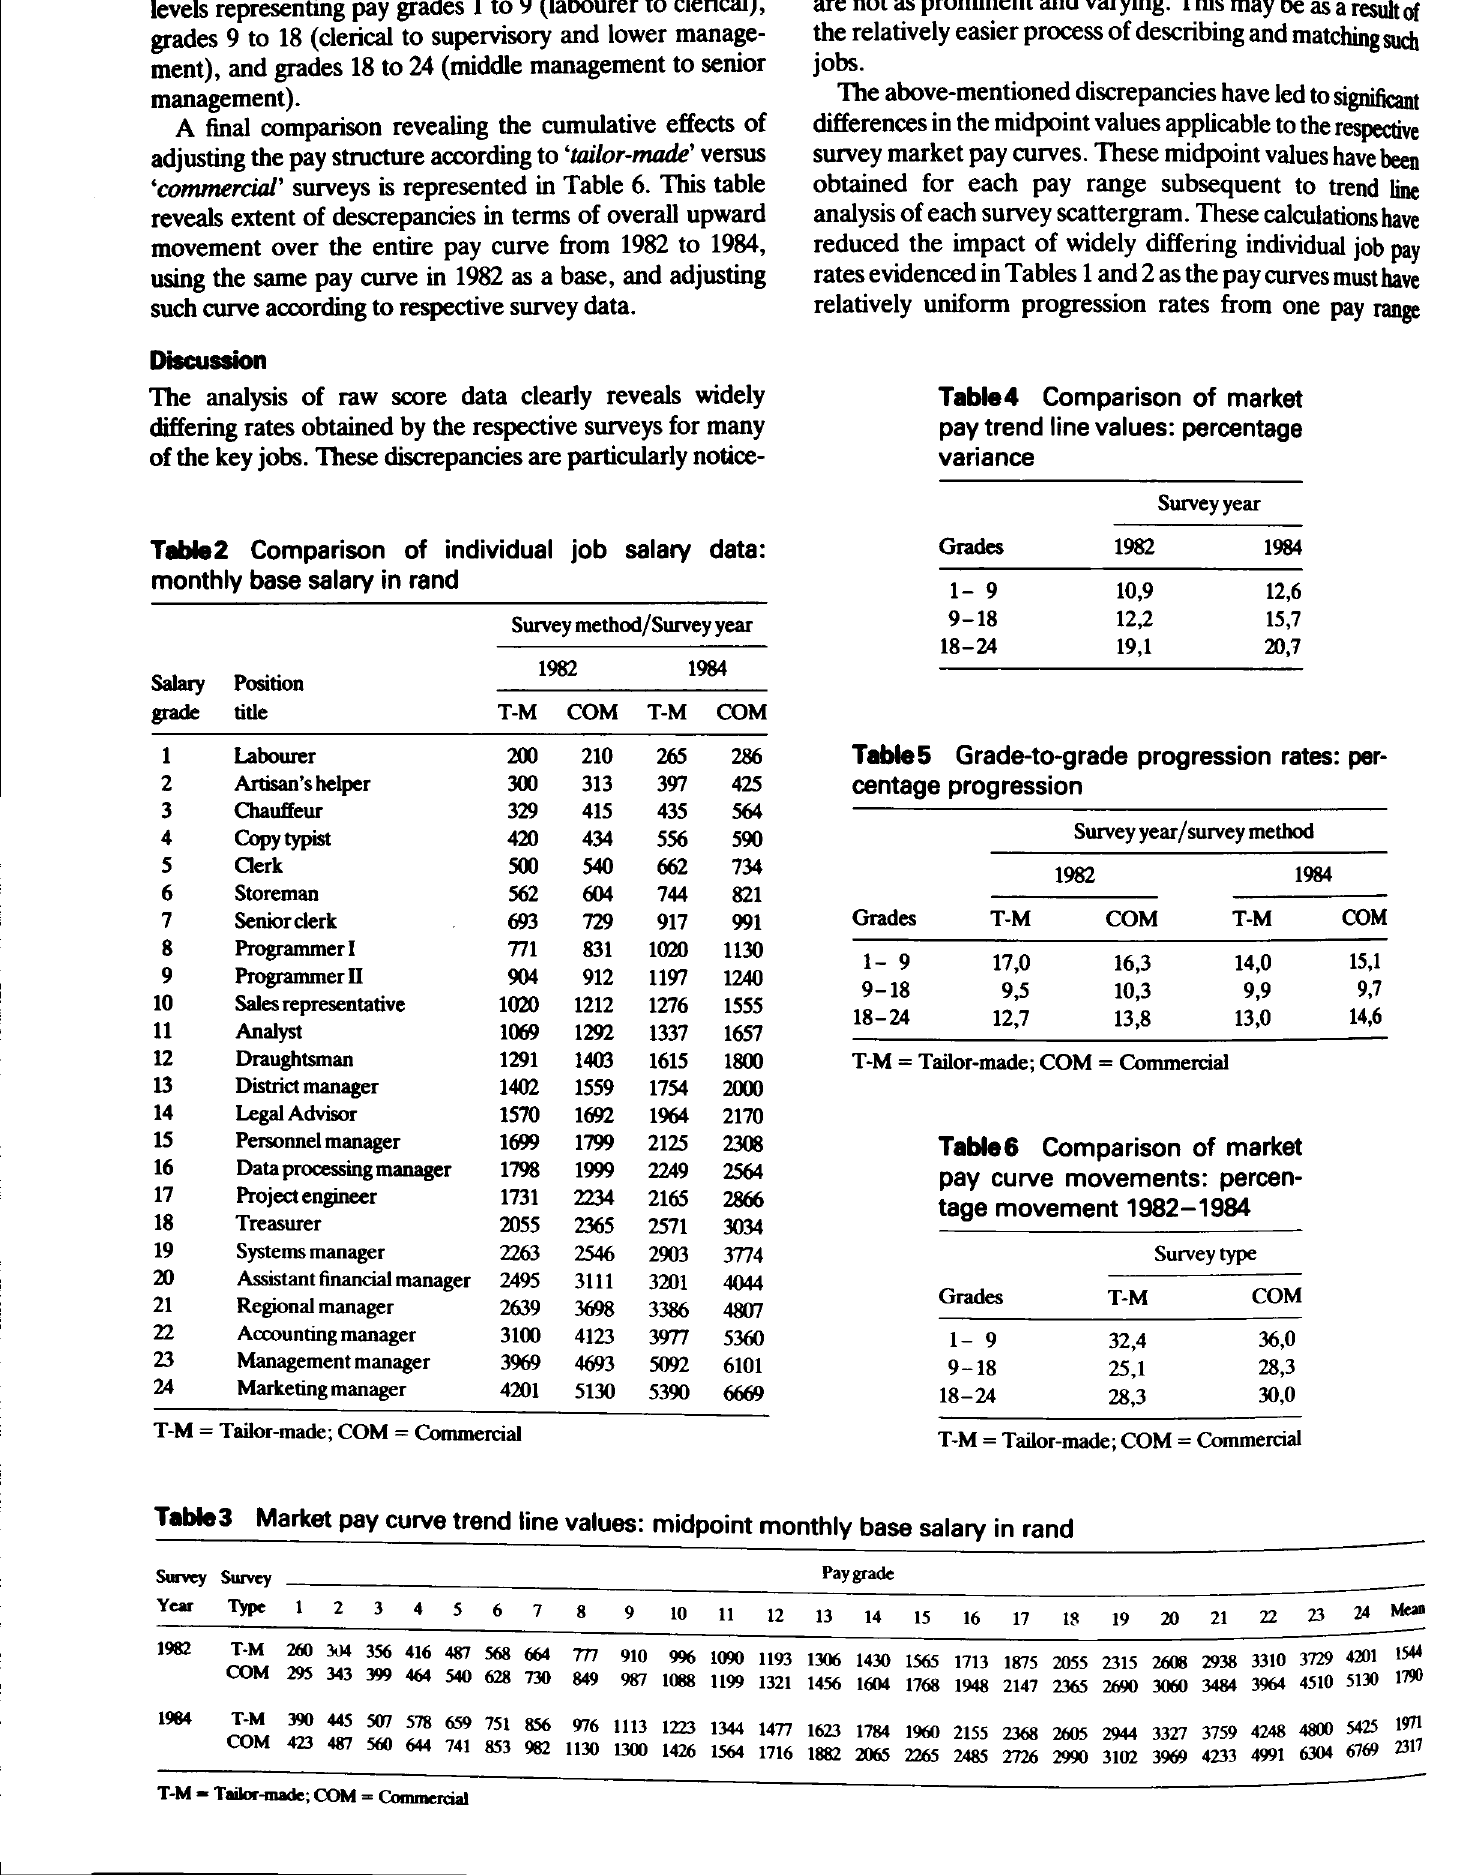
Table3 Market pay curve trend line values: midpoint monthly base salary in rand s-, Survey Pay